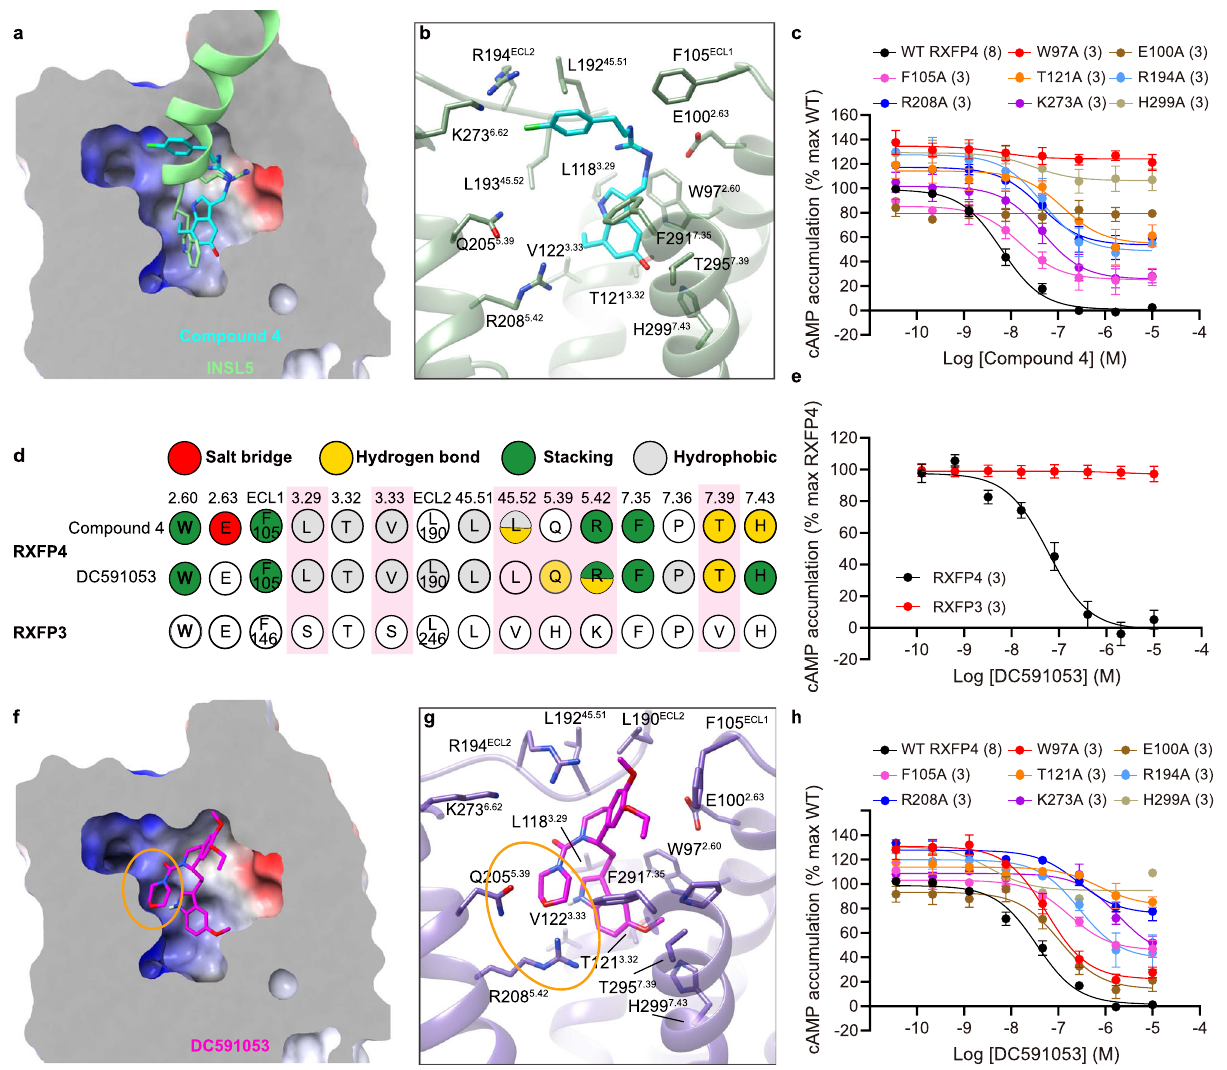
Fig. 3 | Peptidomimetic agonism and subtype selectivity demonstrated by compound4andDC591053.a Thecross-sectionviewofthecompound4binding pocket in RXFP4. b Detailed interactions of compound 4 (cyan) with residues in RXFP4 (dark sea green). c Effects of receptor mutations on compound 4-induced cAMP accumulation. Data are shown as means±S.E.M. of at least three indepen- dent experiments. d Schematic diagram of interactions between ligands and receptor. Amino acid residues of RXFP4 are colored red for salt bridge, yellow for hydrogen bond, green for π - π stacking and gray for hydrophobic interactions. Different residues around the binding pocket in RXFP3 and RXFP4 are highlighted in pink. e Subtype selectivity of DC591053 at RXFP4 without observable cross-